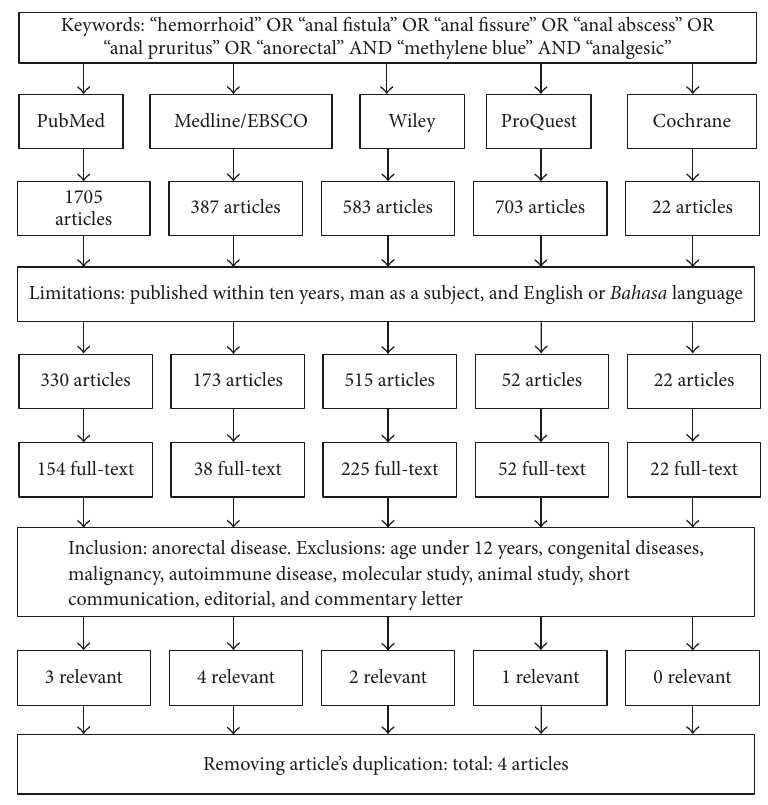
Figure 1: Diagram of the steps of literature